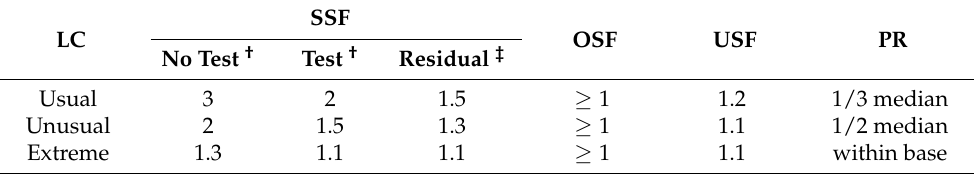
Table 1. Stability